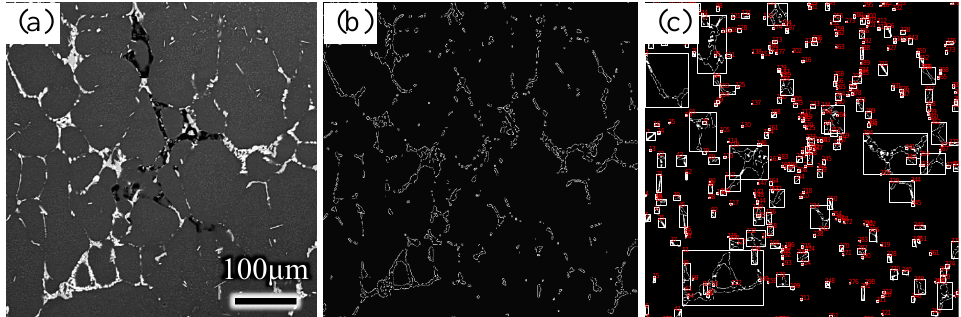
Figure 6. Diagram of inspection. ( a ) Original backscattering SEM image; ( b ) Image after image-marginalization processing; ( c ) image segmentation. Table 2. Parameters of the eutectic phase calculated by the MATLAB program.